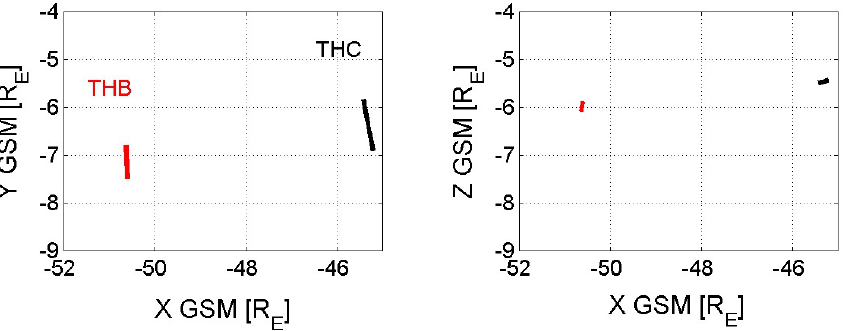
Fig. 1. Positions of the ARTEMIS probes in the GSM coordinate